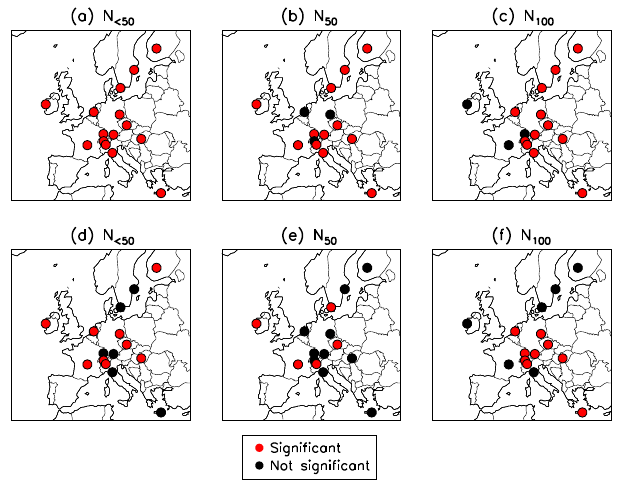
Fig. 6. Statistical significance between hourly-mean modelled and observed particle number concentrations in three size ranges; D p =15–50nm ( N < 50 ), D p > 50nm ( N 50 ), and D p > 100nm ( N 100 ). The red dots show site locations where the difference be- tween the model and observations is statistically significant at the 99% confidence level; the black dots show the locations where the difference is insignificant. (a) , (b) and (c) show results for model experiments without BL nucleation (1–2, Table 2); (d) , (e) and (f) show results for the experiments including BL nucleation (3–10, Table